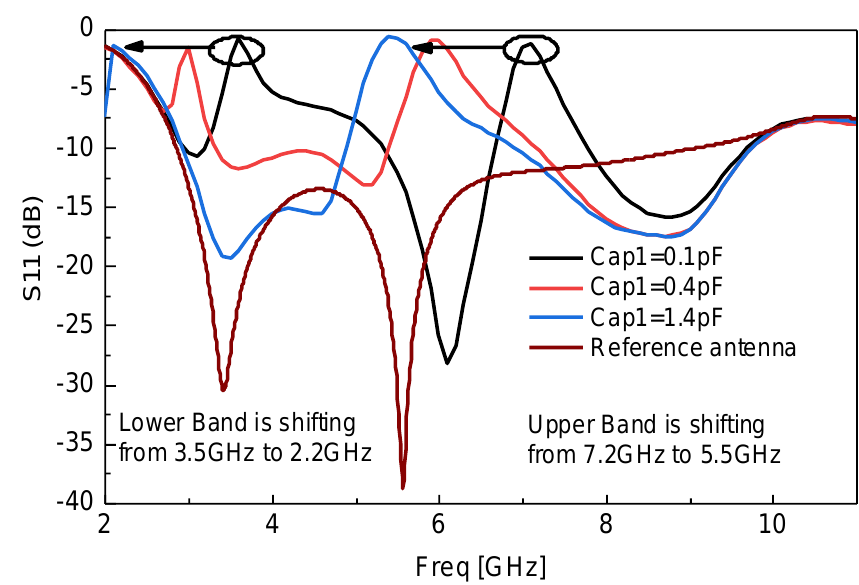
Figure 2. Continuously tunable band-notch behavior of resonator by varying Cap1 only.